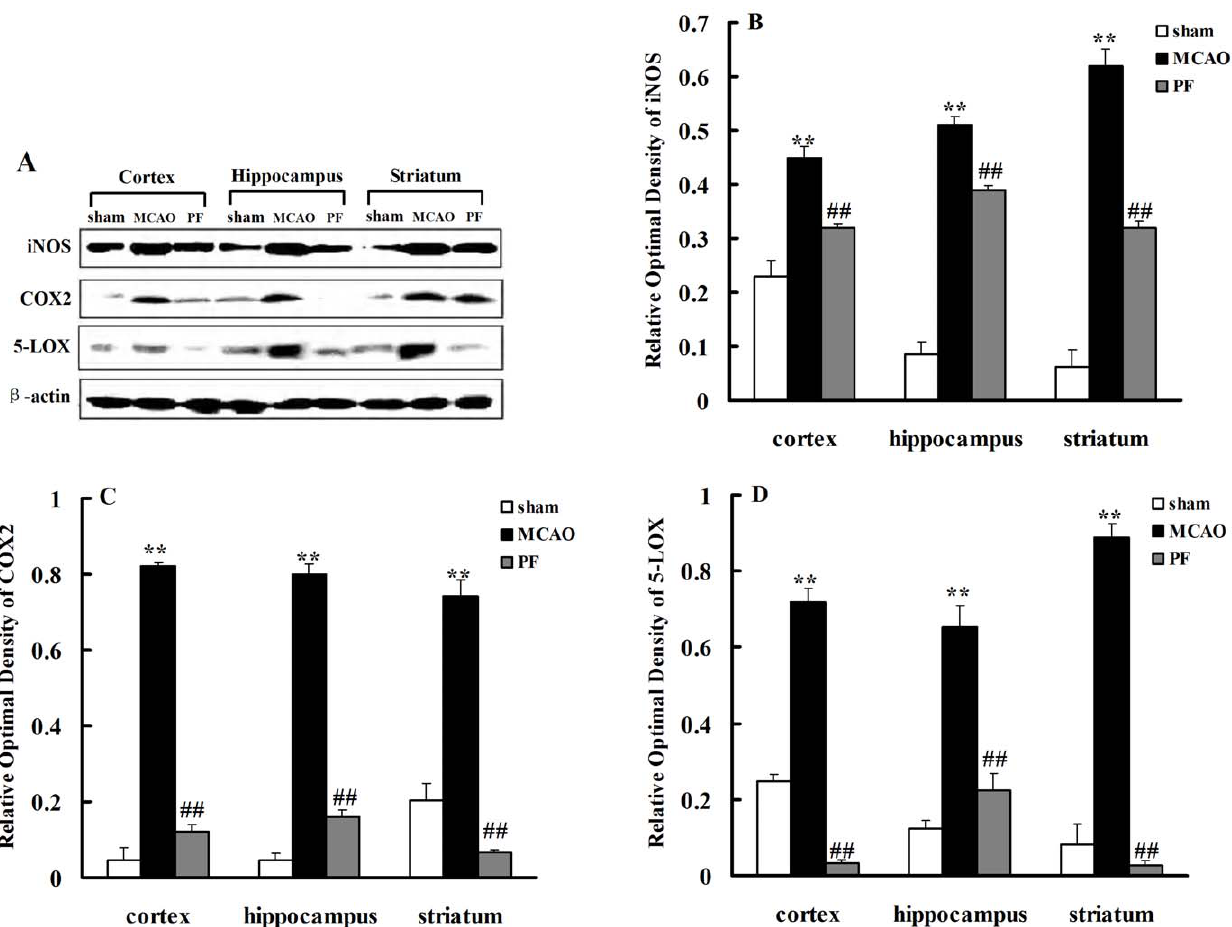
Figure 4. PF treatment inhibits the protein expressions of iNOS, COX-2 and 5-LOX in the brain. (A) represents the protein expression of iNOS, COX-2 and 5-LOX in the cortex, hippocampus and striatum of rats. (B–D) indicates the relative optical density of these proteins expression. Sham, rats received surgery without vessel occlusion; MCAO, rats treated with saline for 14 days after transient MCAO; PF, PF (5 mg. kg 2 1 ) was administered for 14 days after MCAO. n=4. All data were expressed as mean 6 SD. ** P , 0.01 vs sham; ## P , 0.01 vs MCAO.